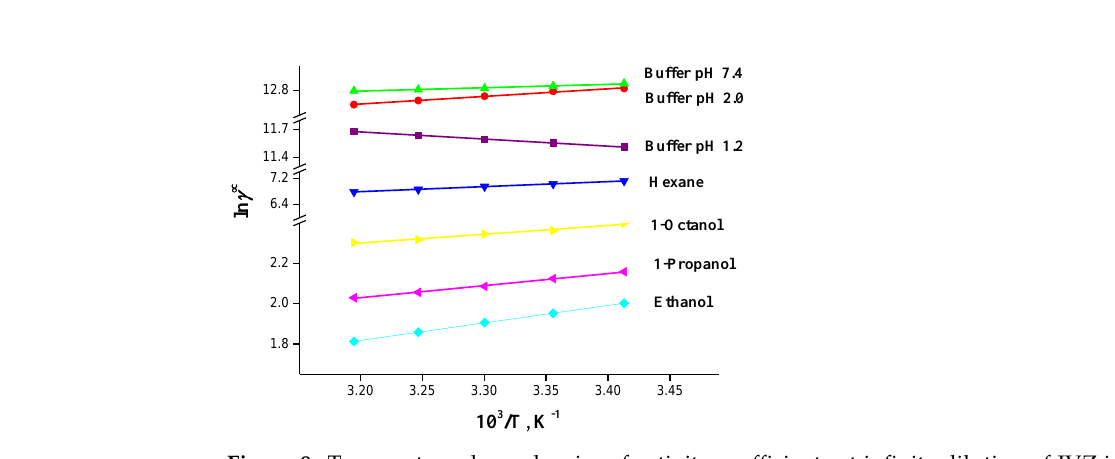
Table 7. Excess thermodynamic solubility functions of IVZ in studied solvents at 298.15 K and p = 101.3 kPa. Solvent